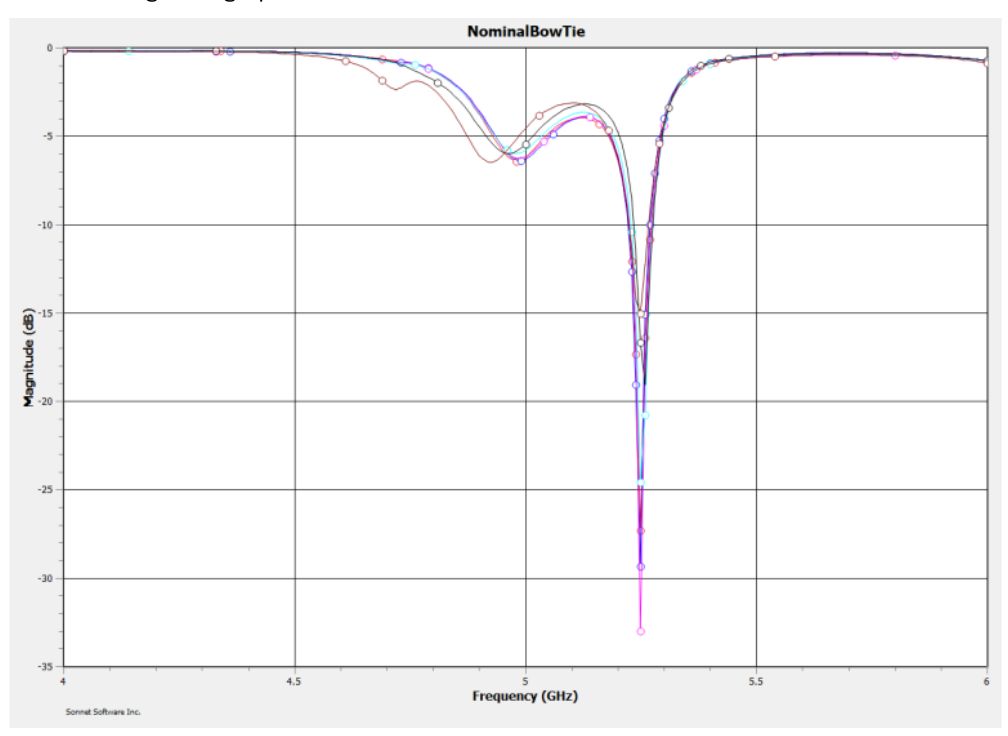
Figure 6. Magnitude/Frequency graph for all angle changes in points B